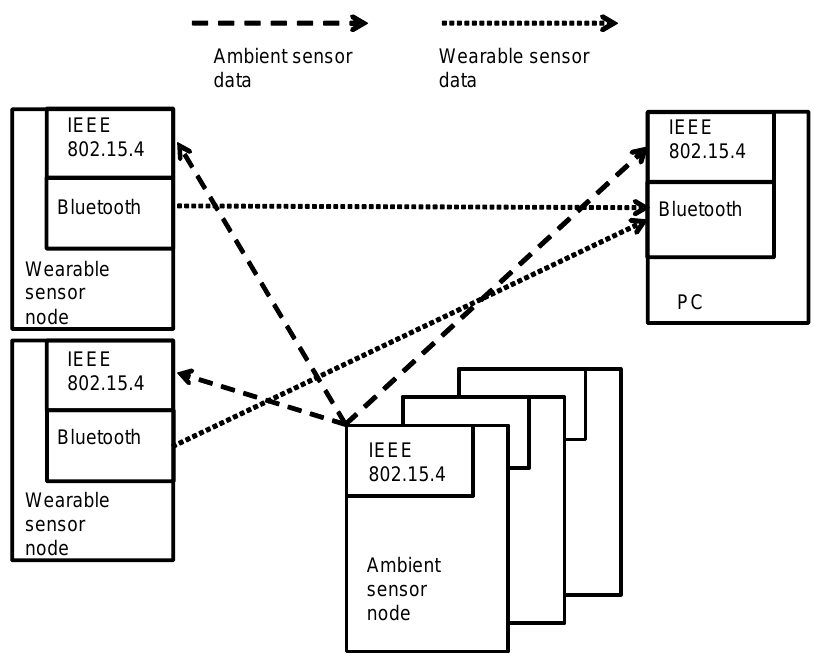
Figure 1. Wearable and ambient